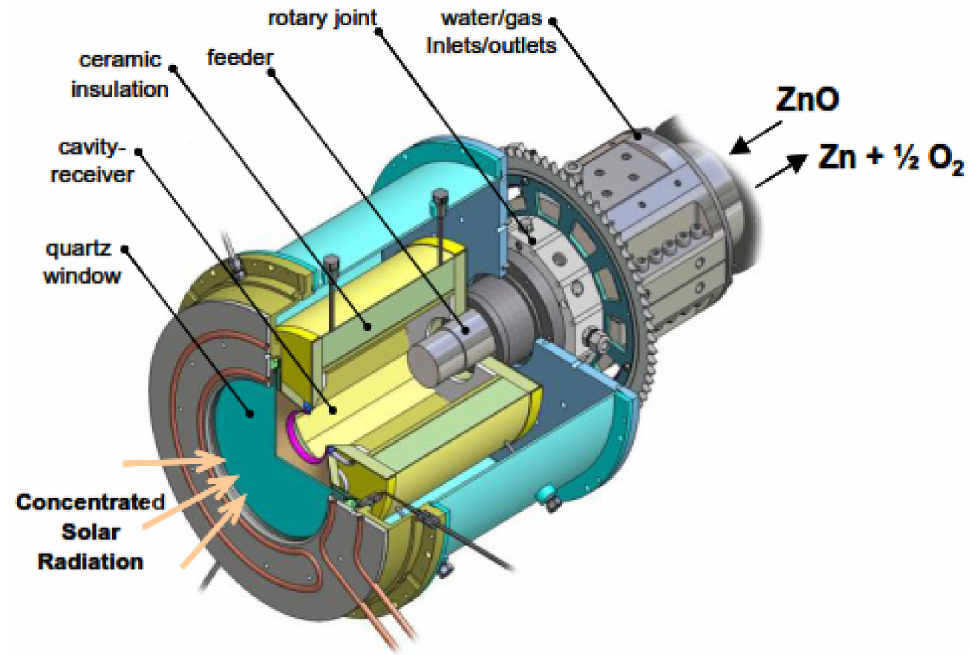
Figure 4. Schematic representation of the 10-kW directly irradiated solar reactor used for thermal decomposition of ZnO to Zn and O 2 , developed at PSI